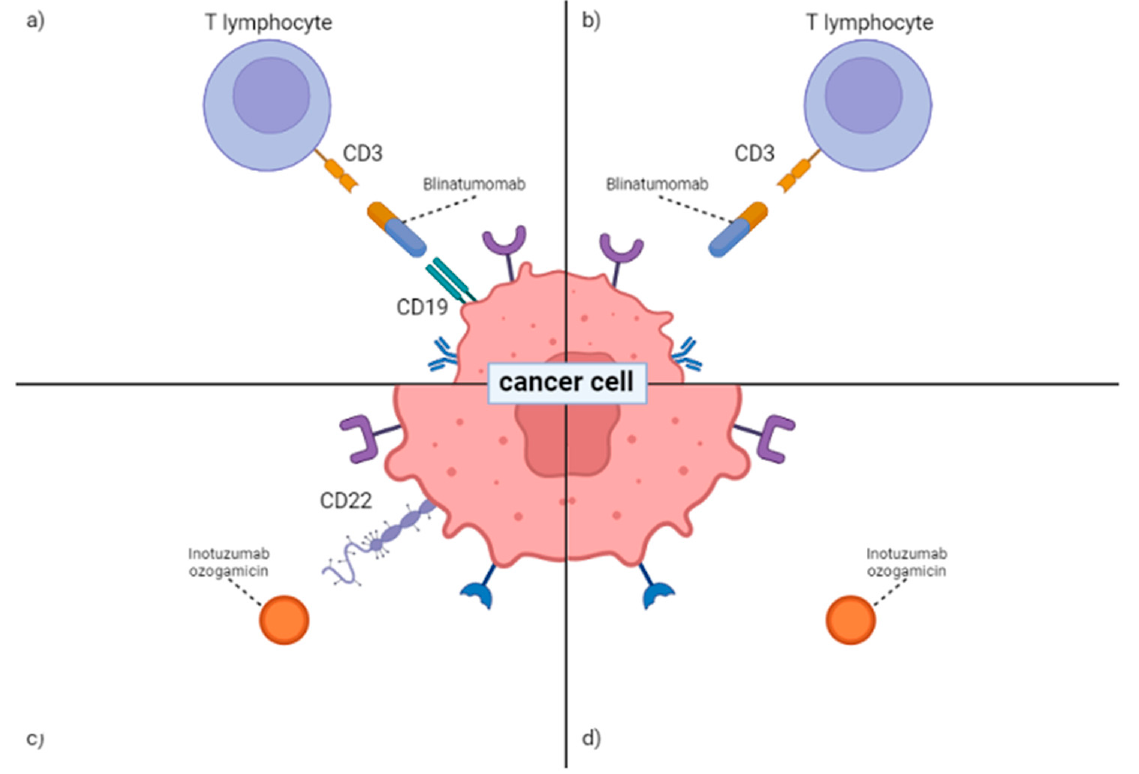
Figure 1. Effect of Blinatumomab and Inotuzumab ozogamicin (InO) on a cancer cell and the mechanism of tumor cell escape. ( a ) Blinatumomab in therapeutic context. Blinatumomab is a mediator between CD19 antigen on T lymphocytes and CD19 antigen localized on cancer cells. Effect of connection is cancer cell death, caused by cytotoxic activity of T lymphocyte; ( b ) Resistance to Blinatumomab. No CD19 antigen on cancer cells leads to no connection between T lymphocyte and cancer cell, where there is no cell death; ( c ) Inotuzumab ozogamicin (InO) in therapeutic context. When CD22 antigens are found on cancer cells, InO binds, and it causes the production of intracellularly unconjugated calicheamicin, which causes blast cell death. ( d ) Resistance to InO. InO has no effect when CD22 antigens are not present on cancer cells. Image created with BioRender.com.